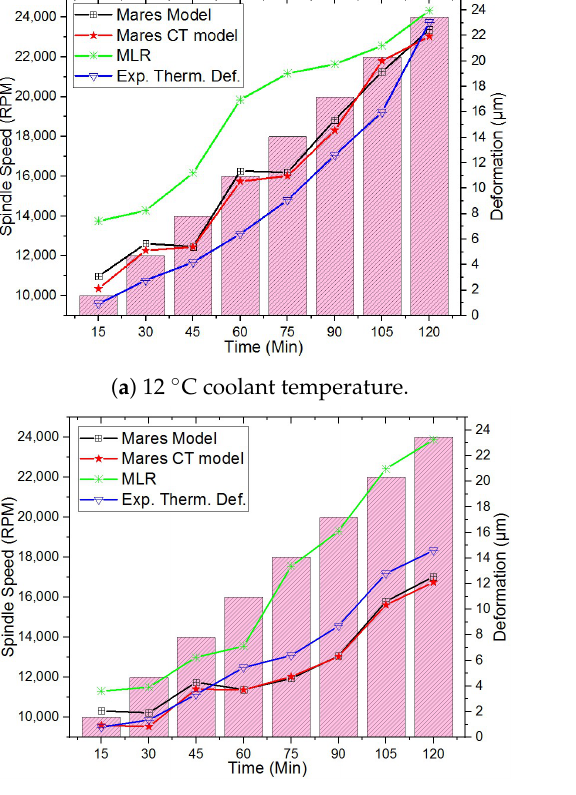
Figure 5. Thermal deformations of the standalone built-in spindle system in the 15 min dynamic operation at the different coolant temperatures and spindle rotating speeds with a constant coolant flow rate of 5 LPM: ( a ) 12 ◦ C coolant temperature; ( b ) 18 ◦ C coolant temperature; ( c ) 20 ◦ C coolant temperature; ( d ) 26 ◦ C coolant temperature.